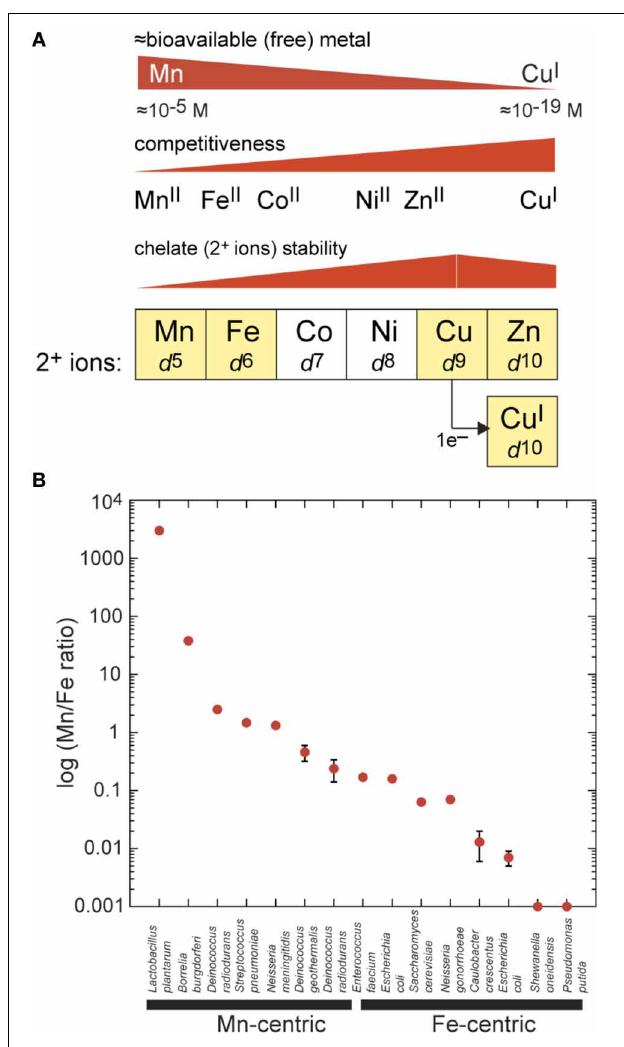
FIGURE 1 | Inorganic chemistry of the cell. (A) Biologically important first-row transition metals extracted from the periodic table from Mn to Zn and with outer (3 d ) shell electronic configurations ( d 5 – d 10 ) as indicated. Zn(II) and Cu(I) both have filled d -shells. Coordination number (CN) preferences move from Mn to Cu(I) from high [CN = 6 for Mn(II)] to low [CN = 2–4 for Cu(I)], which tracks with increasing thiophilicity and polarizability of the metal. The approximate trend in metal(II) complex stability for a mixed N/O ligand donor set is indicated for each metal (Fraústo da Silva and Williams, 2001); this trend is inversely related to competitiveness in a cellular environment which itself is inversely related to “bioavailability” of each metal in the cell. Bioavailability is very roughly based on reported metal sensor affinities for their cognate metal and is not a direct measure (Reyes-Caballero et al., 2011). (B) Total cell-associated log (Mn:Fe ratio) plotted for individual bacteria as measured by ICP-MS. The term Mn-centric is operationally defined here as those organisms for which Mn:Fe ≥ 0.2, or the lower limit obtained for Deinococcus radiodurans under extremely Mn-depleted growth conditions (Daly et al., 2004). Fe-centric refers to those organisms for which Mn:Fe ≤ 0.2. Most of these